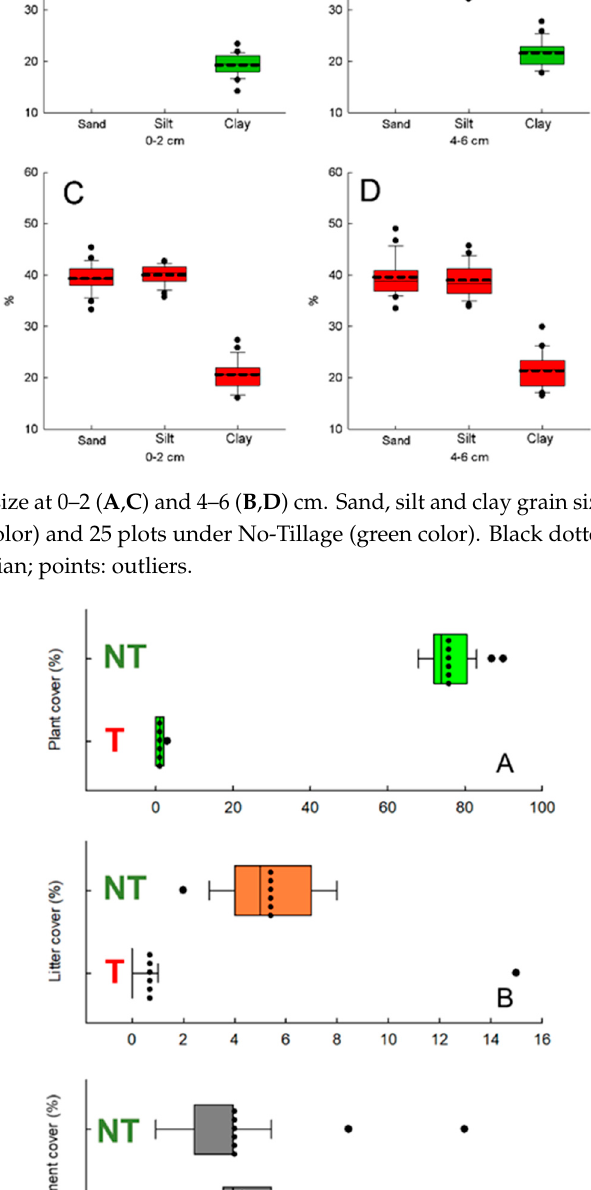
Figure 6. Soil properties at 0–2 (left side) and 4–6 (right side) cm. ( A , B ): bulk density (g cm − 3 ); ( C , D ): organic matter (%); ( E , F ): soil moisture (%) for the 25 plots under Tillage (T) and 25 plots under No- Tillage (NT). Black dotted line: mean values; black thin line: median; points: outliers.